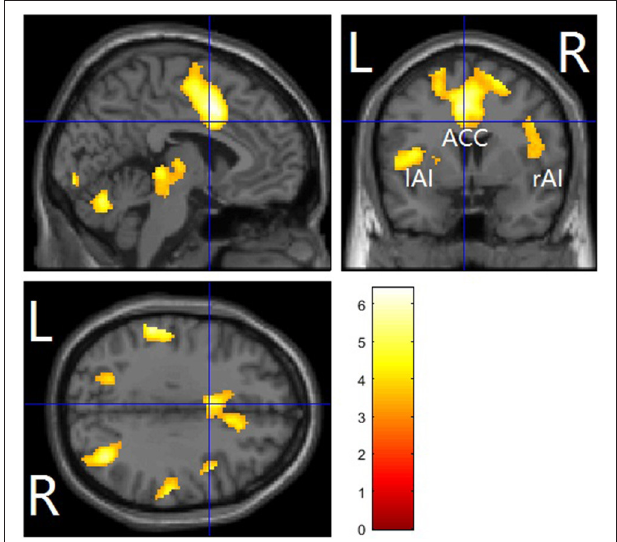
FIGURE 2 | Pain vs. nopain across sobriety /intoxication in a whole-brain analysis. The affective pain matrix was displayed. Voxel-wised threshold was set at p = 0.001, FDR corrected at cluster-level. L, left; R, right; ACC, anterior cingulate cortex/supplementary motor area; AI, anterior insula.